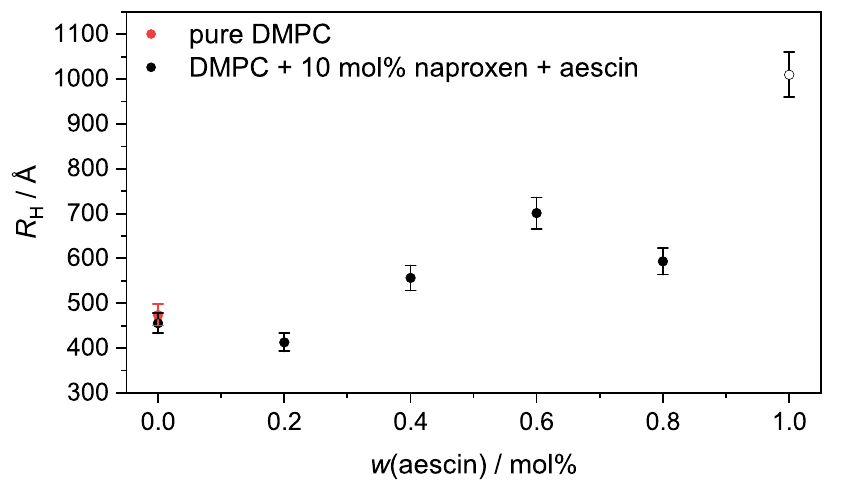
Figure 11. R H at T = 10 °C of the DMPC vesicles containing 10mol% naproxen and aescin is plotted as a function of w (aescin). The red circle depicts the hydrodynamic radius of pure DMPC